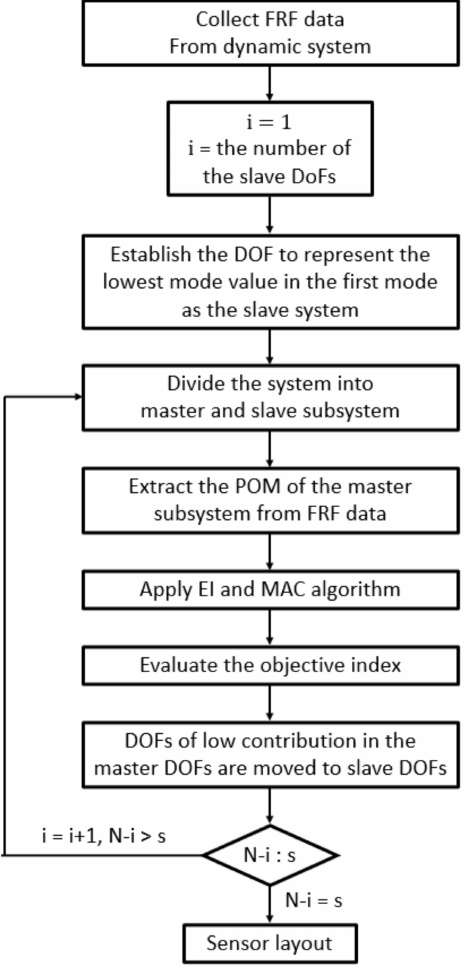
Figure 1. Flow chart of the proposed OSP